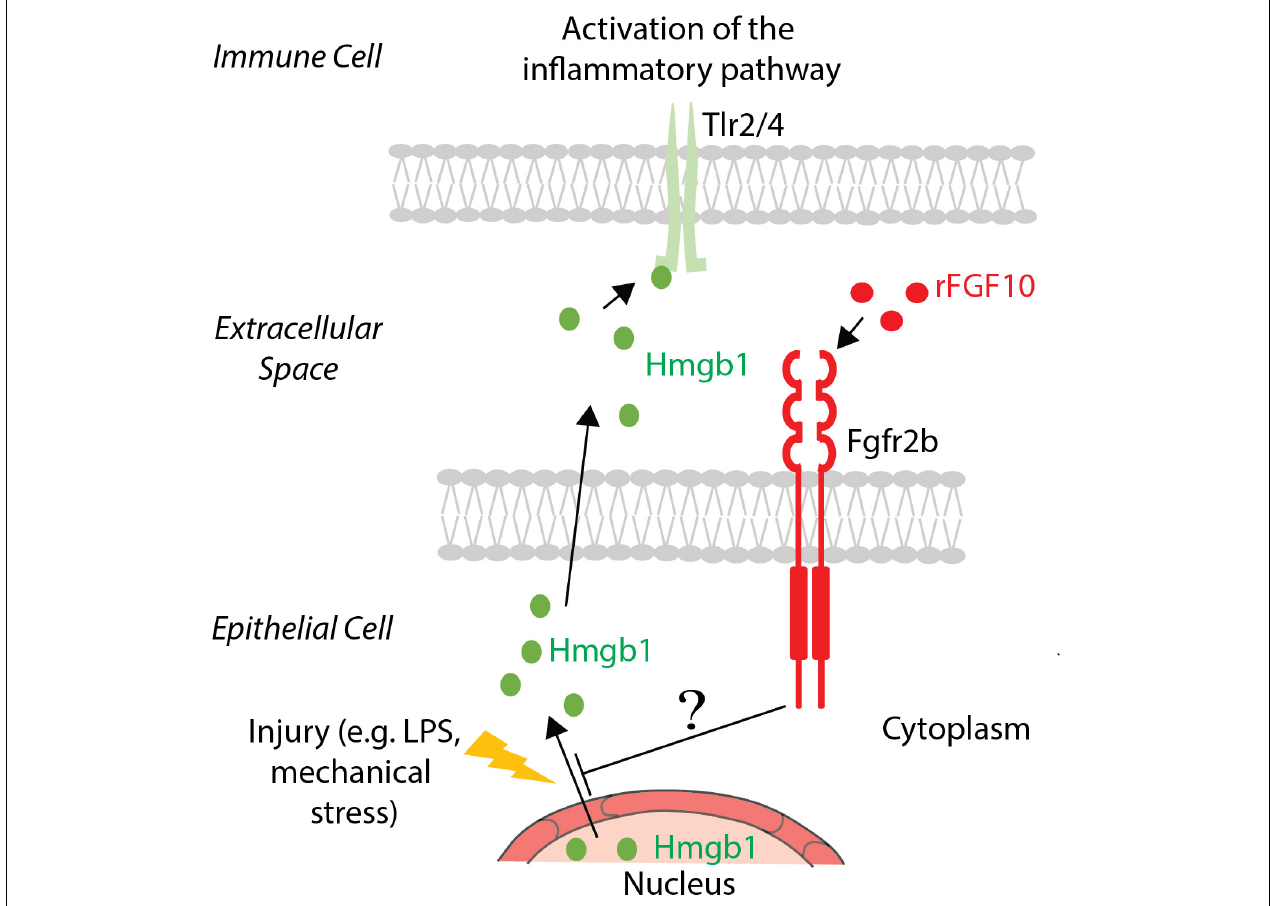
FIGURE 2 | FGF10 effect on Hmgb1. In the case of injury, Hmgb1 shuttles from nucleus to the cytoplasm of the epithelial cells to be released in the extracellular space, where it could bind its receptors Tlr2/4 present on the immune cell surface, causing an inflammatory response. Exogenous FGF10 blocks the release in the extracellular space, acting on the shuttling of Hmgb1 from the nucleus to the cytoplasm. The involved mechanism and the mediators are still